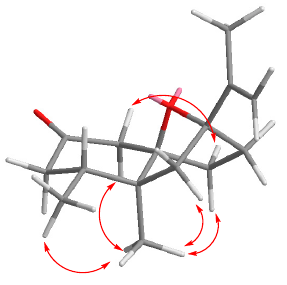
Figure 2. Selected NOEs observed for compound 7 .